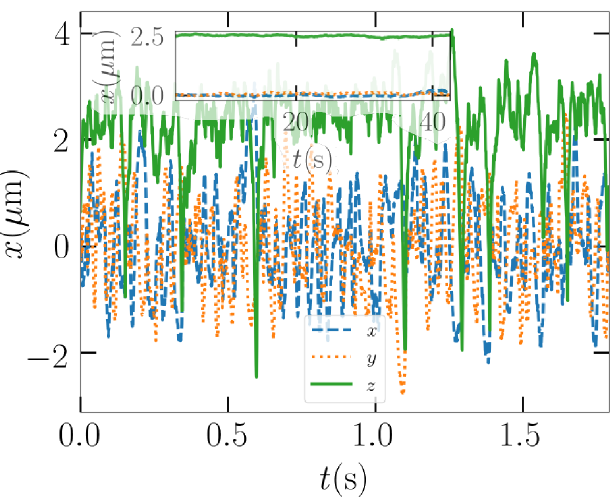
Fig 14. The path of the example Gaussian ellipsoid of size 1 μ m when Brownian forces are present. The inset figure shows the rolling time average of the position over 40 seconds. Note the slightly transparent inset axis labels.